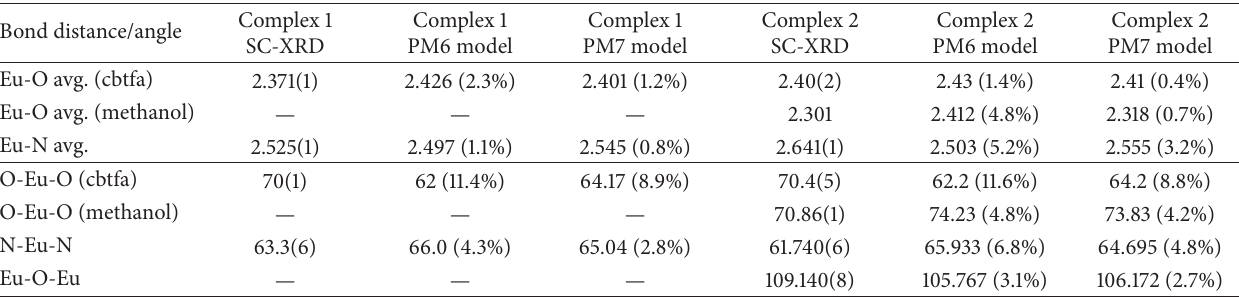
Table 4: Comparison of the experimental and calculated average Eu-N and Eu-O distances (in ˚A) and selected angles (in ∘ ) for the mononuclear (monomer 1) and the homodinuclear Eu 3+ complexes. In parentheses, for the experimental values, standard deviation is shown; for theoretical values, percent error is